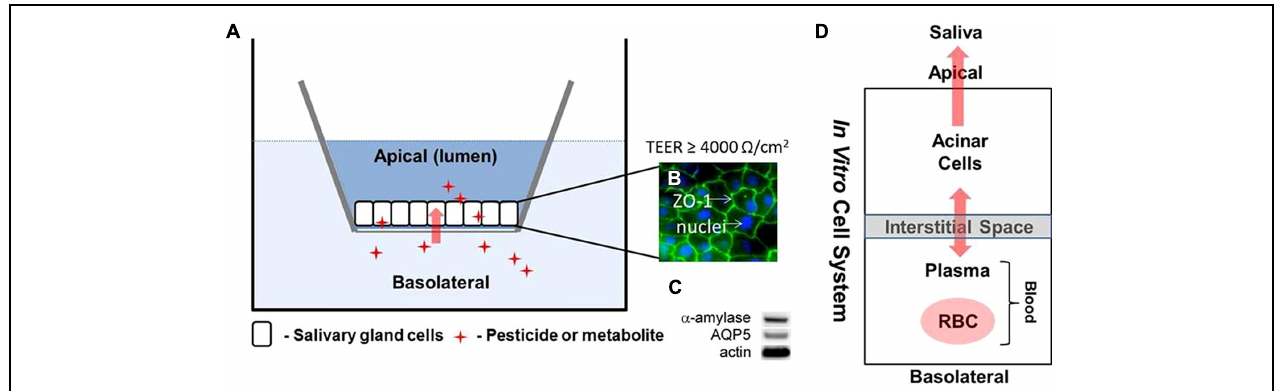
FIGURE 6 | Schematic model illustrating (A,B) Transwell R (cid:4) with salivary gland epithelial cell (SGEC) system. The tight junction marker zona occludins-1 (ZO-1) localizes to points of cell–cell contact in association with excellent tight junction formation as indicated by measurements of transepithelial